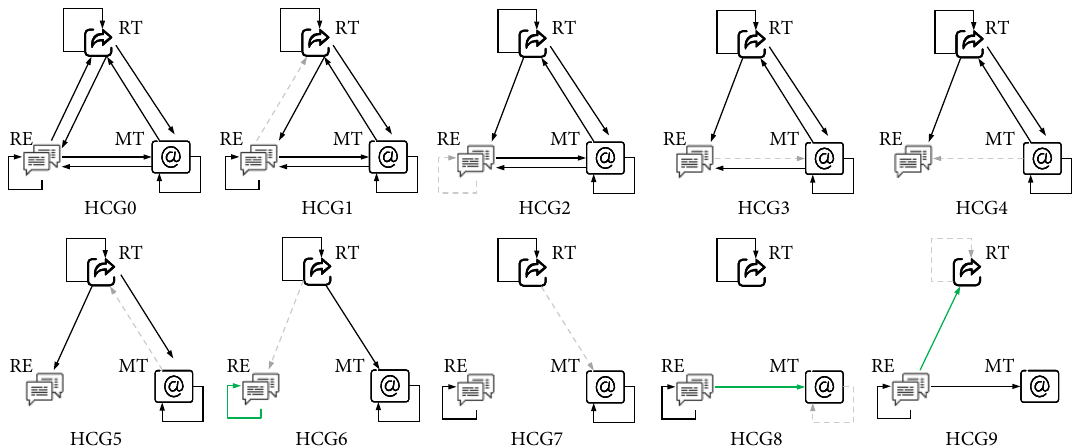
λ Fig. 10 All constructed statistical priority based HCGs. Lines with gray dotted style are removed links in this HCG as increases. Lines in green are added links